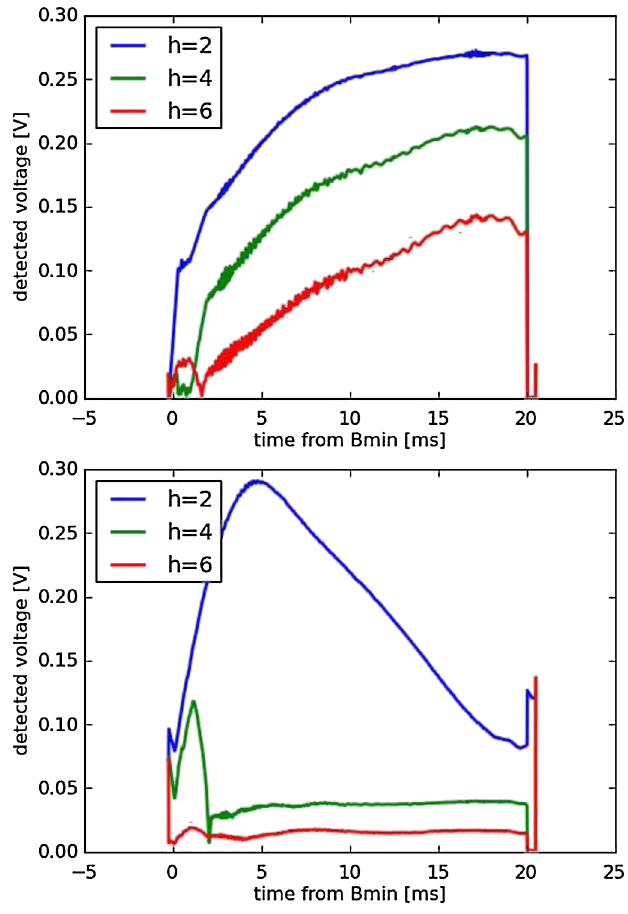
FIG. 13. Step 2 example (cavity #1). The harmonic compo- nents of (top) the WCM and (bottom) the cavity